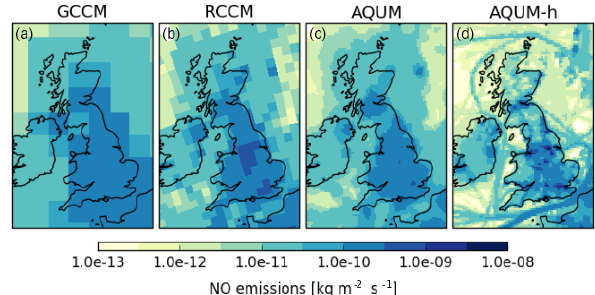
Figure 2. NO emissions for all models: GCCM (a) , RCCM (b) , AQUM (c) , and the higher-resolution emissions run (AQUM-h) (d) .